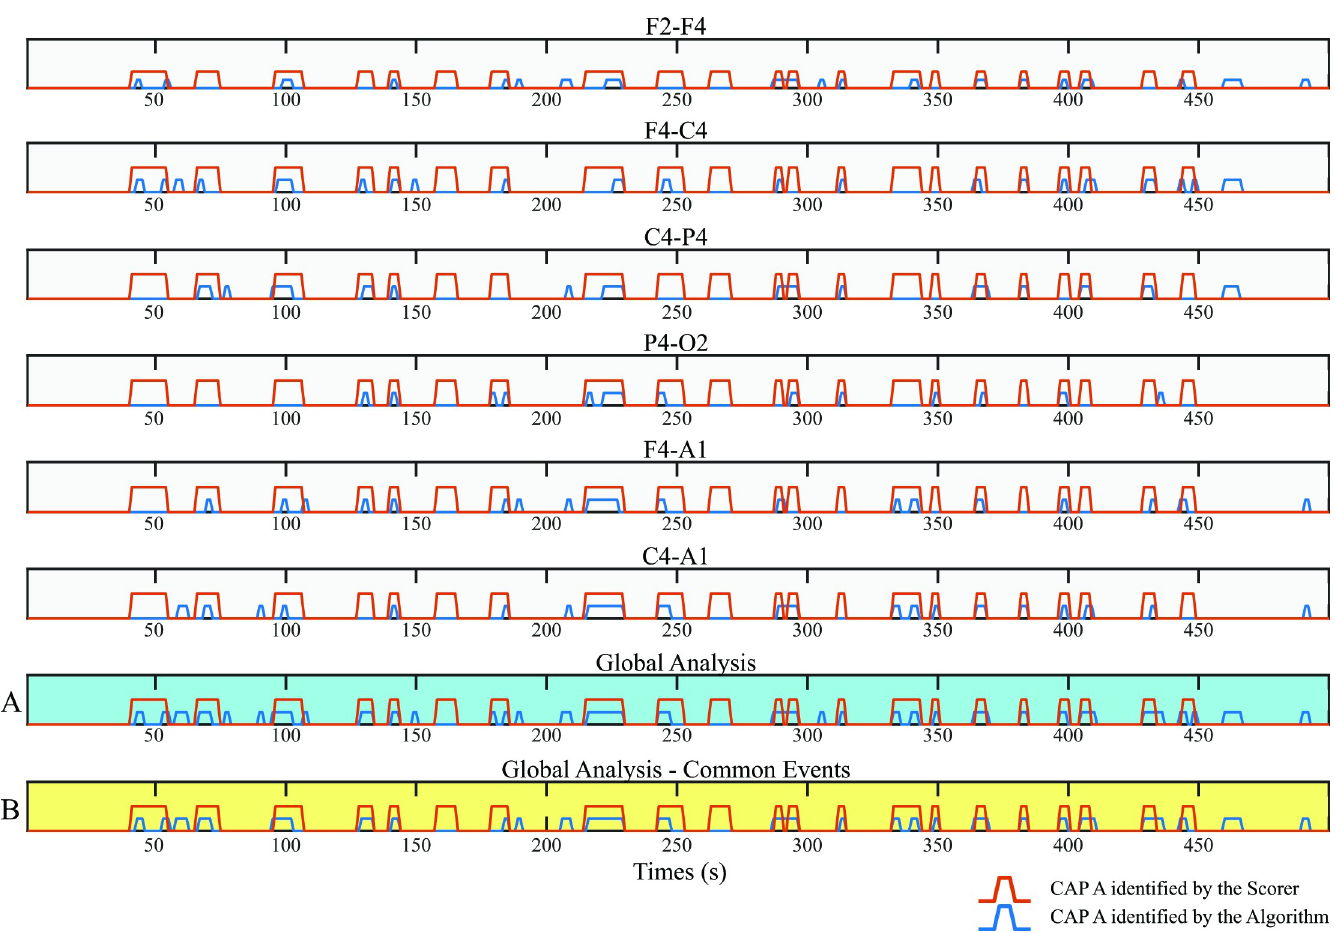
Fig 2. Graphic representation of the CAP A events identified by the algorithm (blue line) and by the scorer (red line). The first six rows from the top refer to a single analysed derivation (see row title). A and B represent the multi-trace approach. The raw with cyan background (A) represents the Global Analysis: all the events identified for each derivation analysed were pulled together and considered as CAP A definitive event. The raw with yellow background (B) represents the Global Analysis—Common Events.